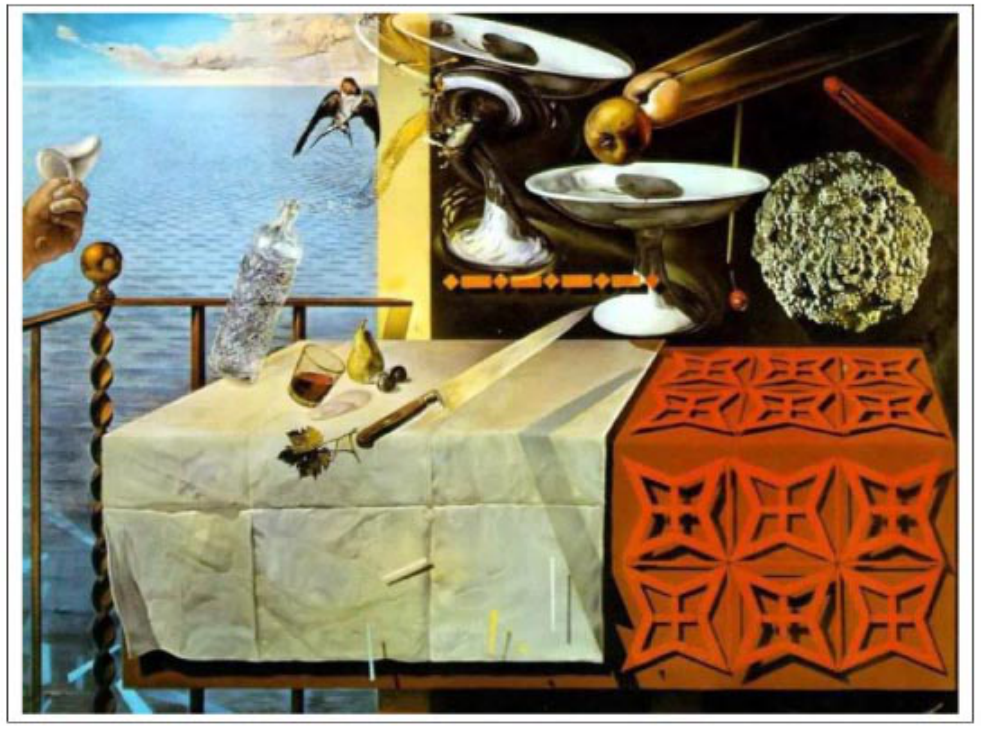
Fig. 2 . The challenge of integrating diverse disciplinary perspectives is to retain the precision of diverse elements of the whole to create an overarching picture. The results may seem strange, unrealistic, and surprising, but they allow for novel approaches and new questions to arise. The painting is Nature Morte Vivante (Still Life Moving Fast) by Salvador Dali, 1956, 125x160 cm. The original is in the Salvador Dali Museum, St. Petersburg, Florida,